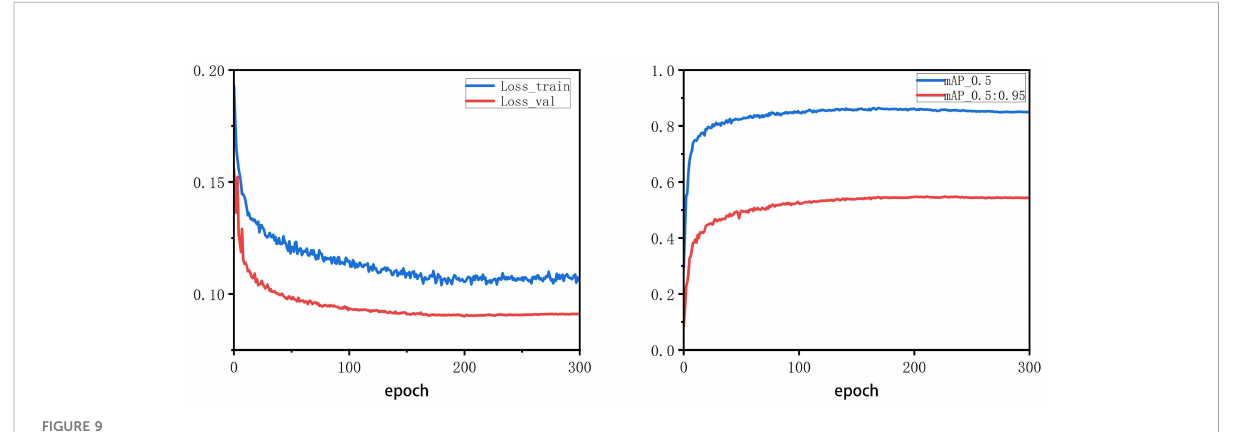
FIGURE 9 Model training convergence process.